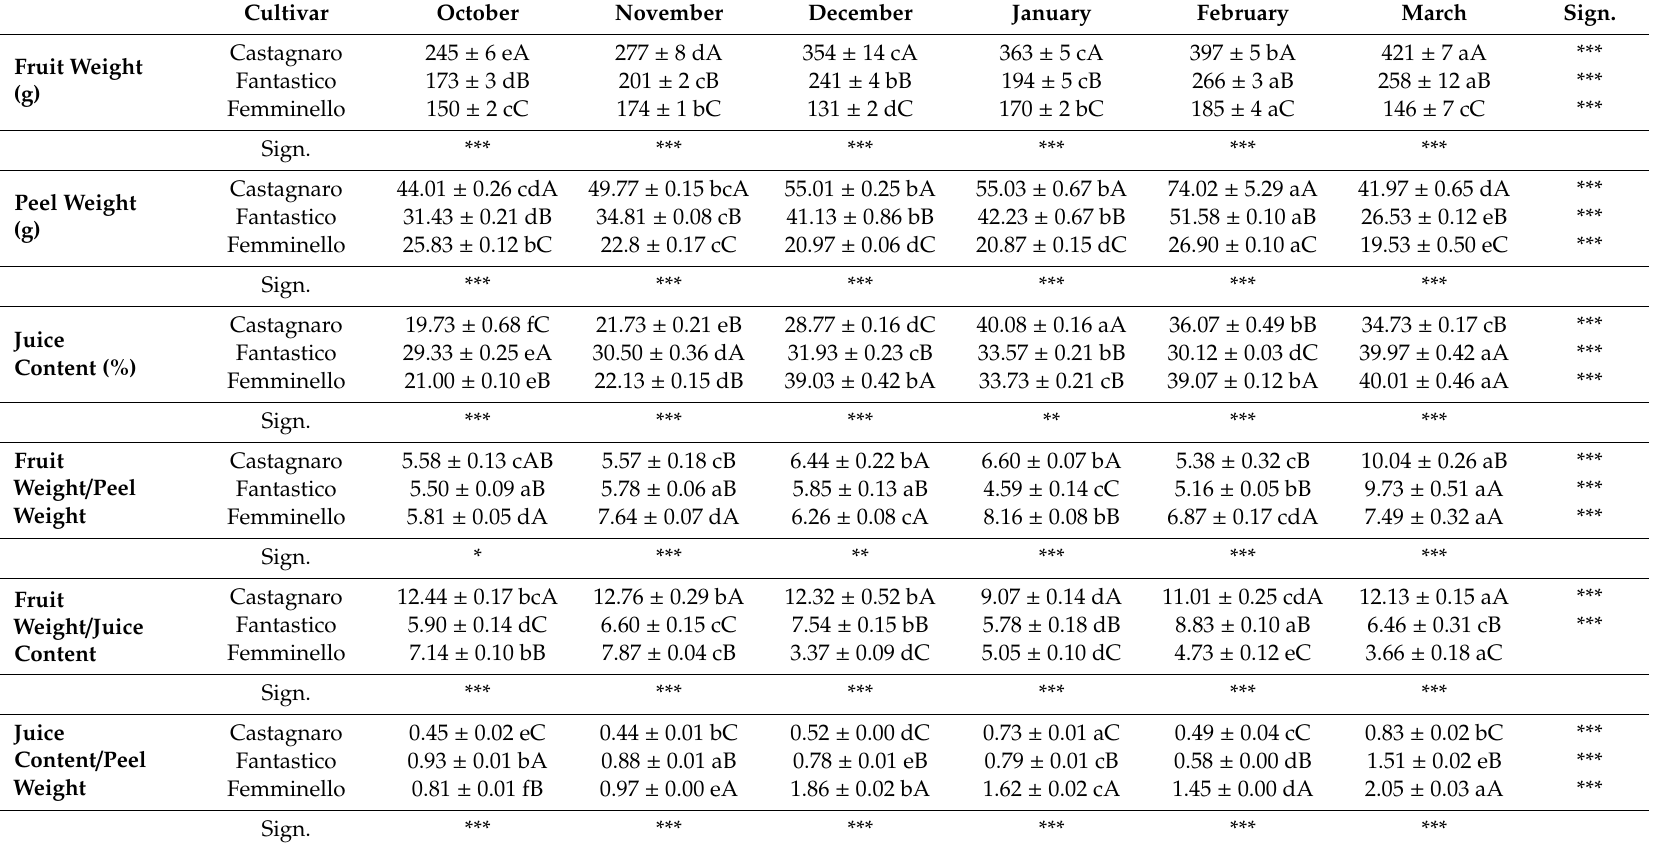
Table 3. Biometrics of bergamot fruit. Results are presented as the mean value ± standard deviation, n = 8, (2016–2017 and 2017–2018 harvest years). *** significance at p < 0.001; ** significance at p < 0.01; * significance at p < 0.05. Means in the same line are distinguished by small letters. Means in the same column are distinguished by capital